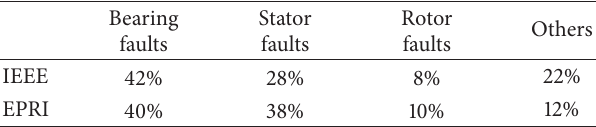
Table 1: Typical induction motor faults and the corresponding occurrence possibilities.